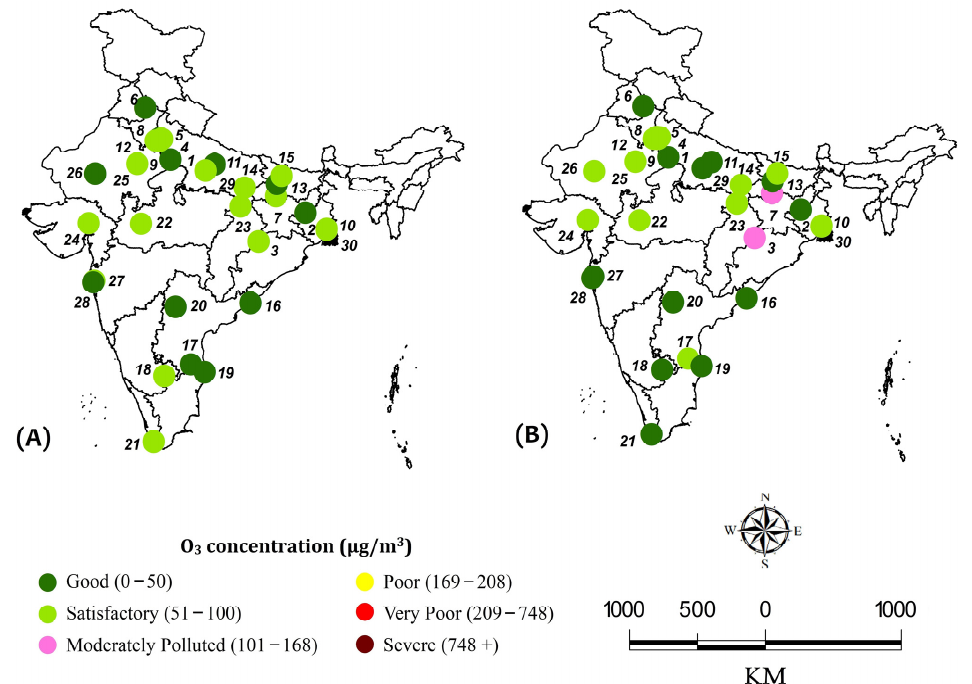
Figure 2. Spatio-temporal variations in O 3 concentration for 30 selected Indian cities. ( A ) 17 January to 24 March 2020. ( B ) 25 March to 31 May 2020. 1. Agra 2. Asansol 3. Brajrajnagar 4. Delhi 5. Fa-